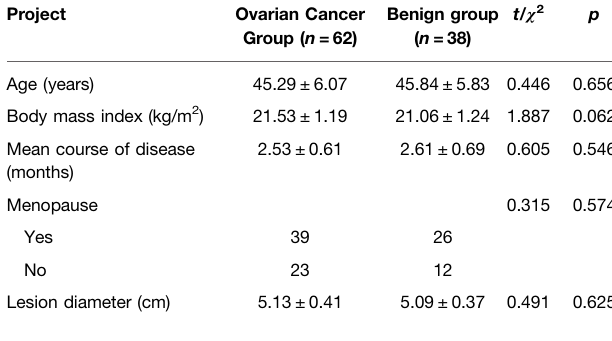
TABLE 1 | Comparison of general information of patients between the two groups ( n , %, (cid:1) x + s).